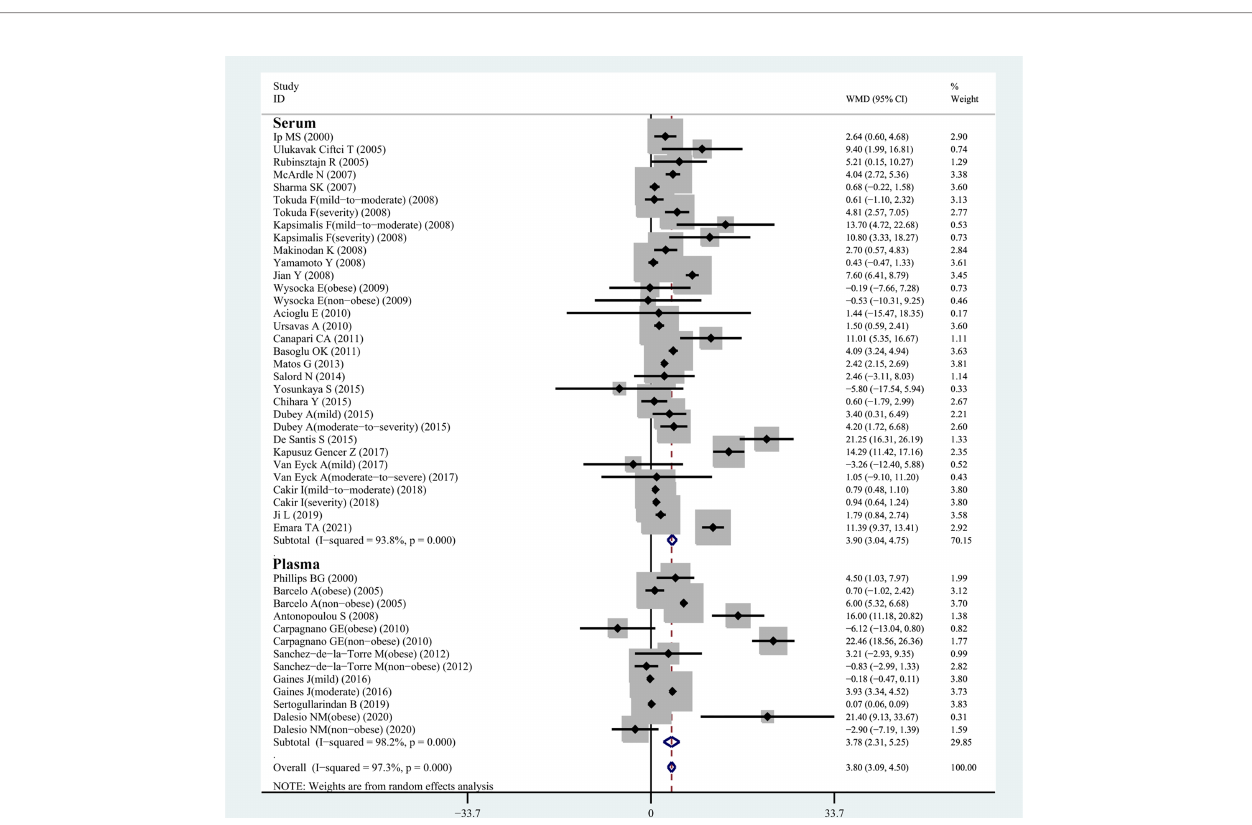
FIGURE 2 | WMD forest plot and 95%CIs for serum leptin levels in the OSAS group in control with the control group in the meta-analysis. 95%CI, 95% con fi dence interval; OSAS, obstructive sleep apnea syndrome; WMD, weighted mean difference.